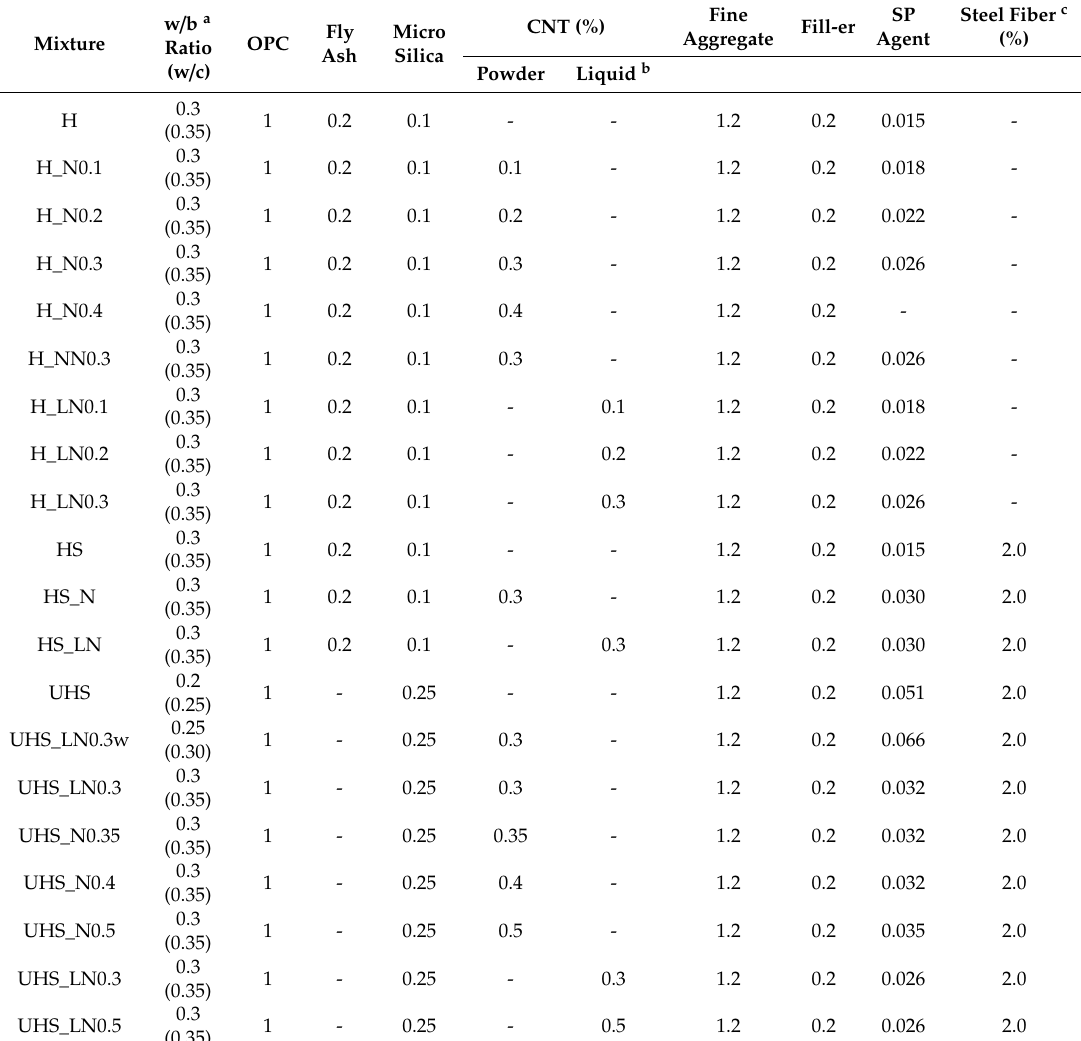
Table 3. Mix ratio of